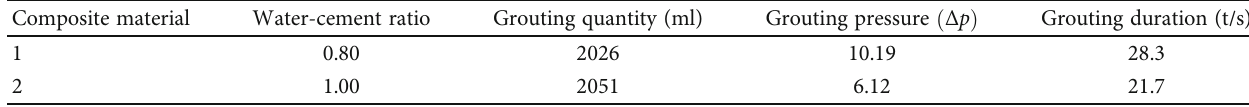
Table 1: Design parameters of cement slurry.